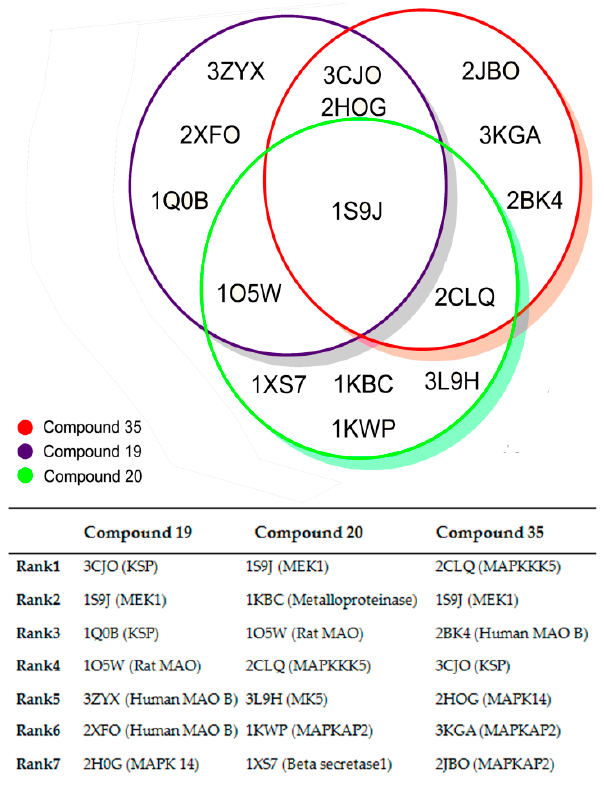
Figure 6. The result of the pharmMapper, 1s9j was the common target.